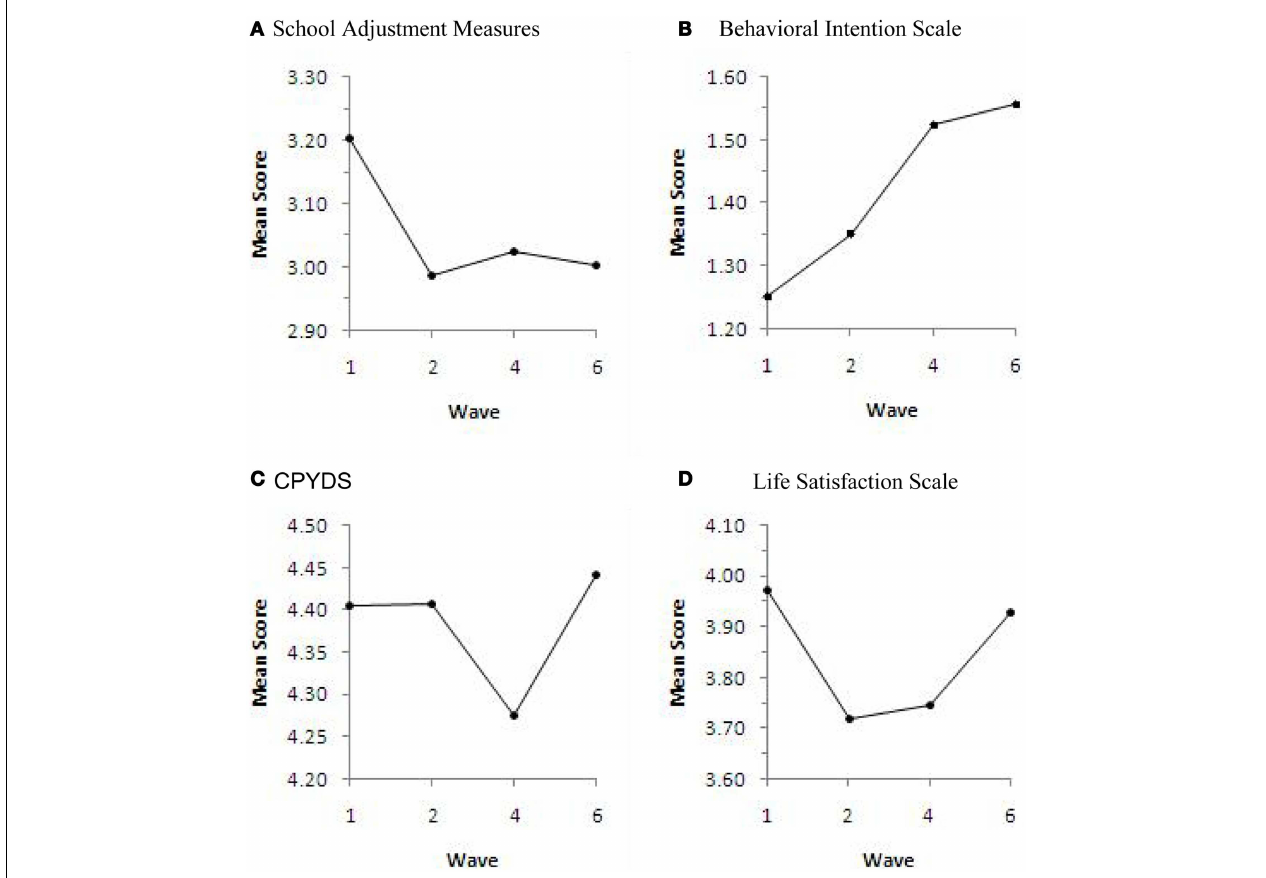
FIGURE 1 |The participants’ response based on different scales at different time-points .Wave 1, Secondary 1 pre-test (baseline);Wave 2, Secondary 1 post-test;Wave 4, Secondary 2 post-test;Wave 6, Secondary 3